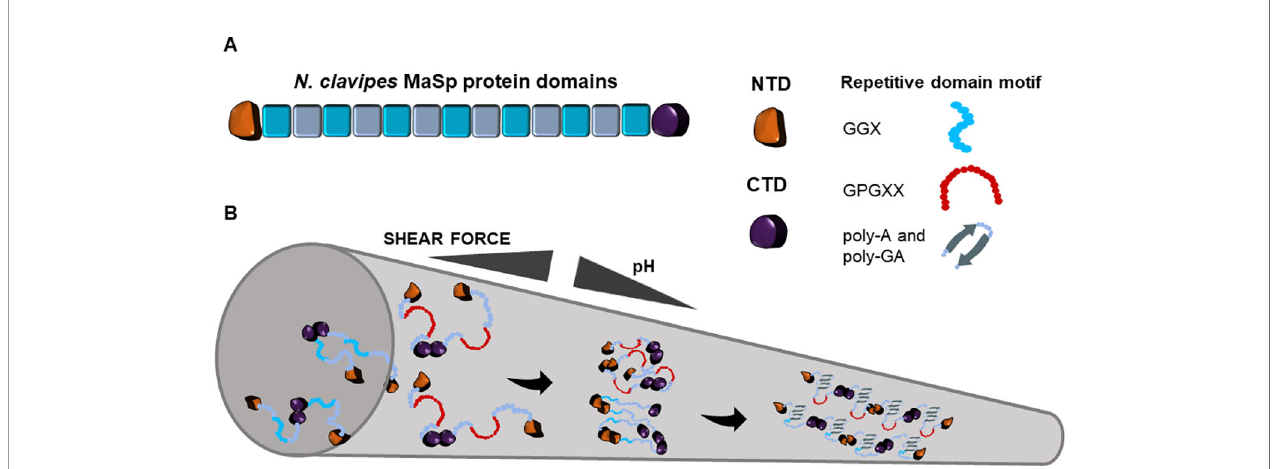
FIGURE 1 | Schematic representation of Nephila clavipes major ampullate spidroin domains (A) and the fi ber assembly model in major ampullate spinning duct (B) . The colored blocks represent repeat blocks with the color variation indicating the glycine-rich motif and the poly-alanine motif. Along the tapered spinning duct, with the increase of shear force and the decrease of pH, N. clavipes major ampullate spidroins transit from the liquid unfolded state into oligomeric state through the dimerization of N-terminus and the facilitation of C-terminus. The oligomeric state ultimately transitions into a two-phased state, which is comprised of unordered amorphous regions and ordered b -sheet crystalline